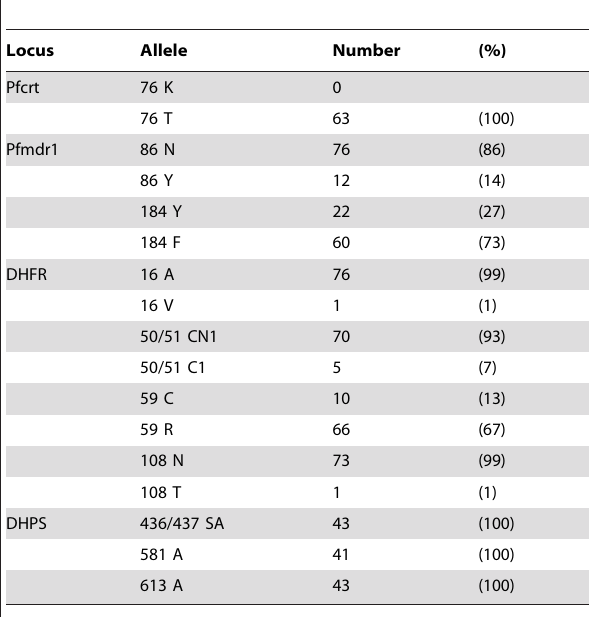
Table 6. Drug resistance alleles in a sub-set collected at